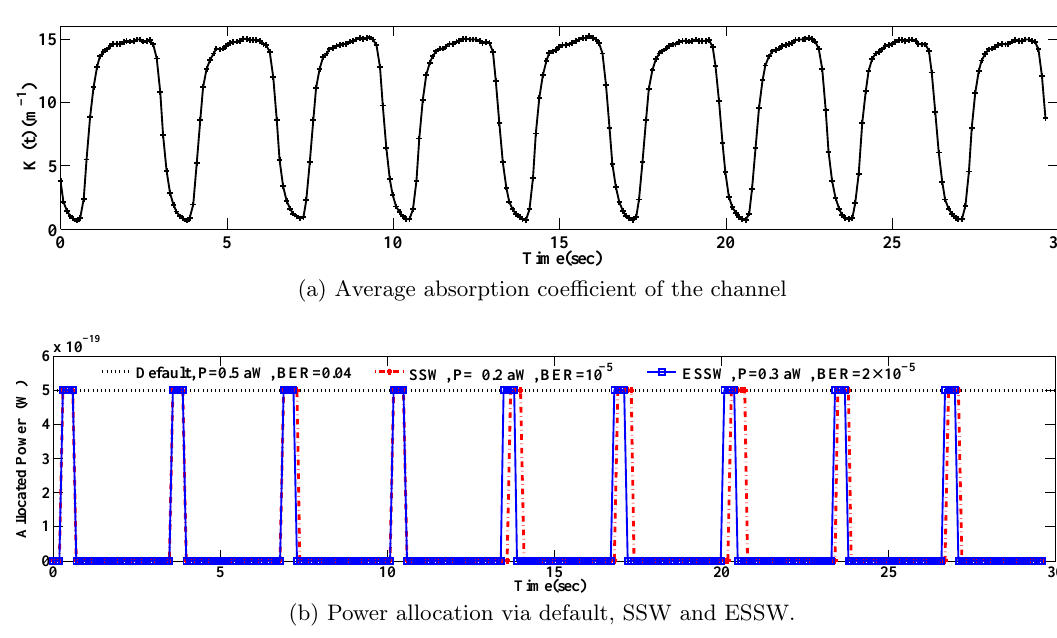
Figure 5: Channel status and power allocation via different protocols within alveolus medium over 9 respiration cycles (nominal power equal to 0.5 aW).